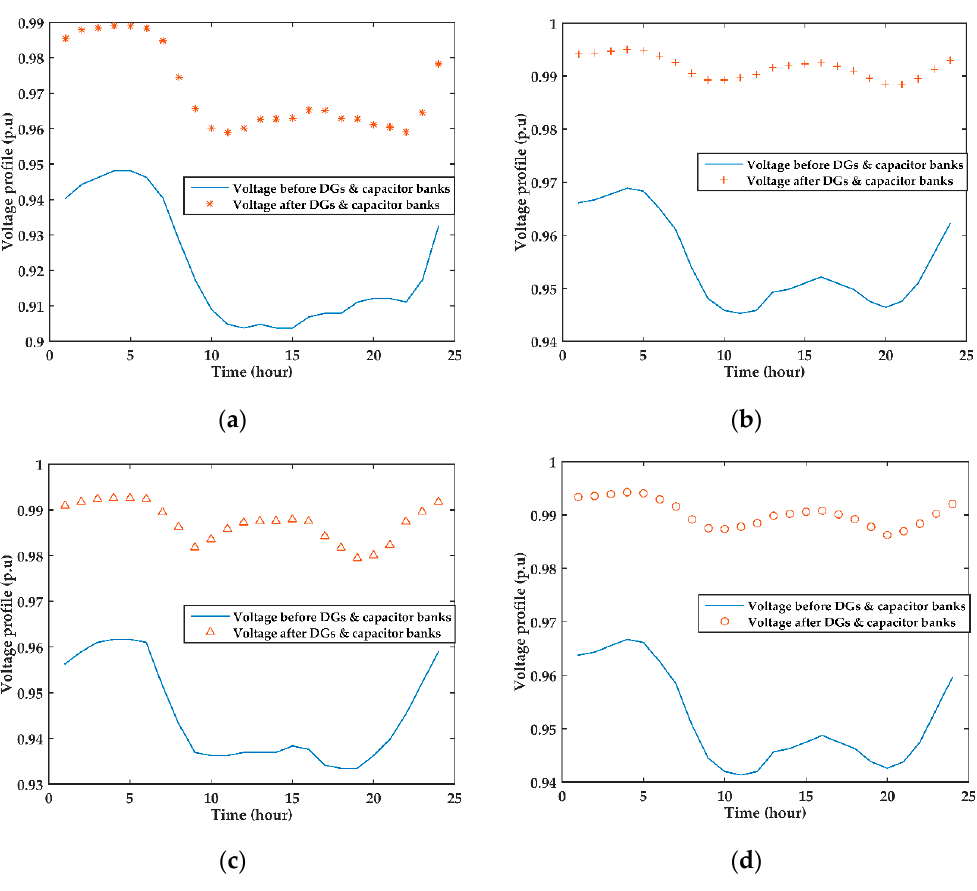
Figure 11. ( a ) Summer; ( b ) autumn; ( c ) winter and ( d ) spring average minimum voltage profile values before and after installation of distributed generation and capacitor banks.